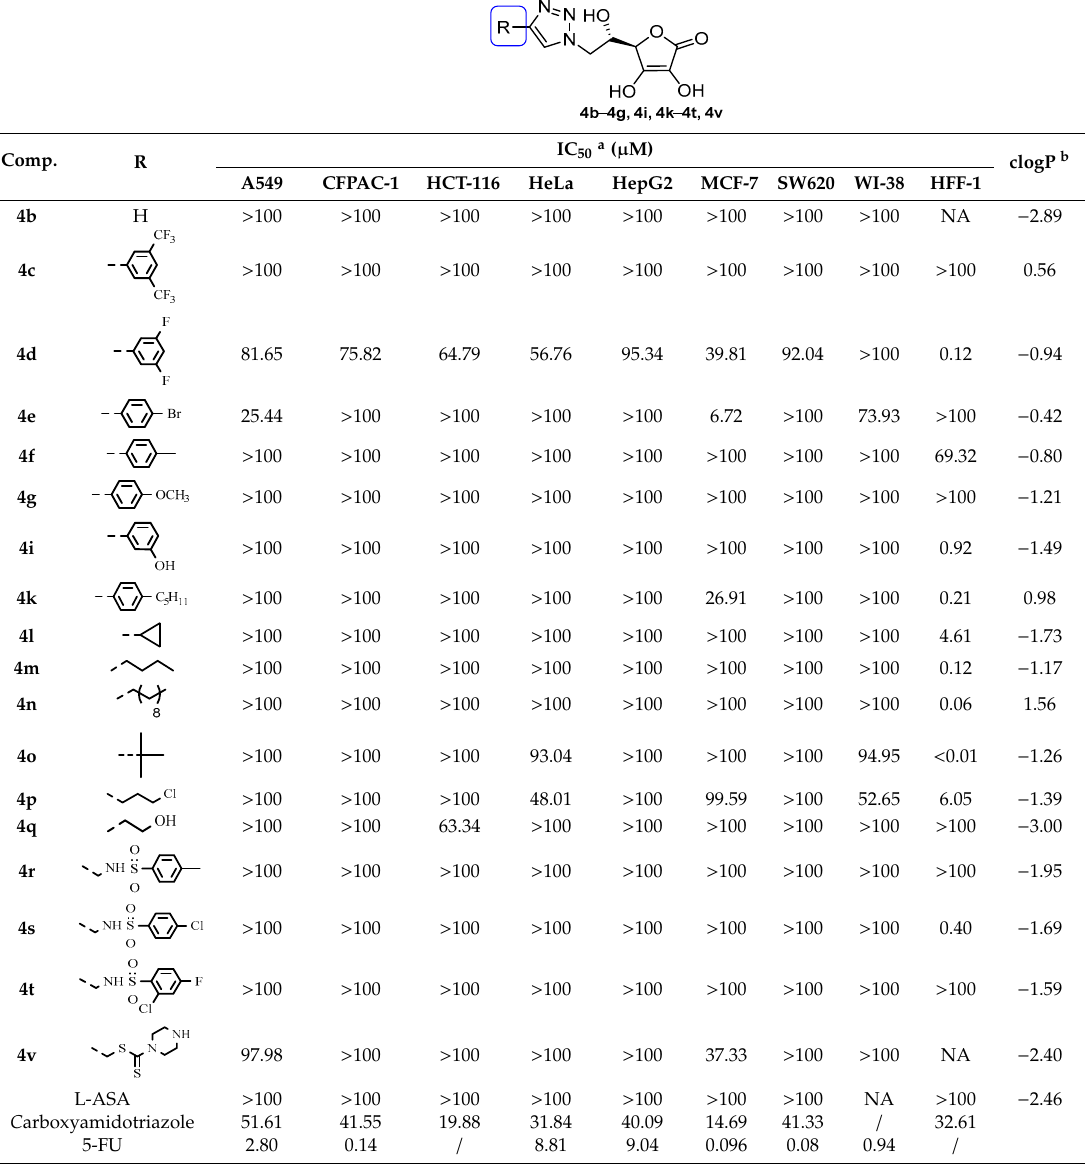
Table 3. The IC 50 values ( µ M) for compounds 4b–4g , 4i , 4k–4t , and 4v for tested cell lines. Int. J. Mol. Sci. 2019 , 20 , x FOR PEER REVIEW